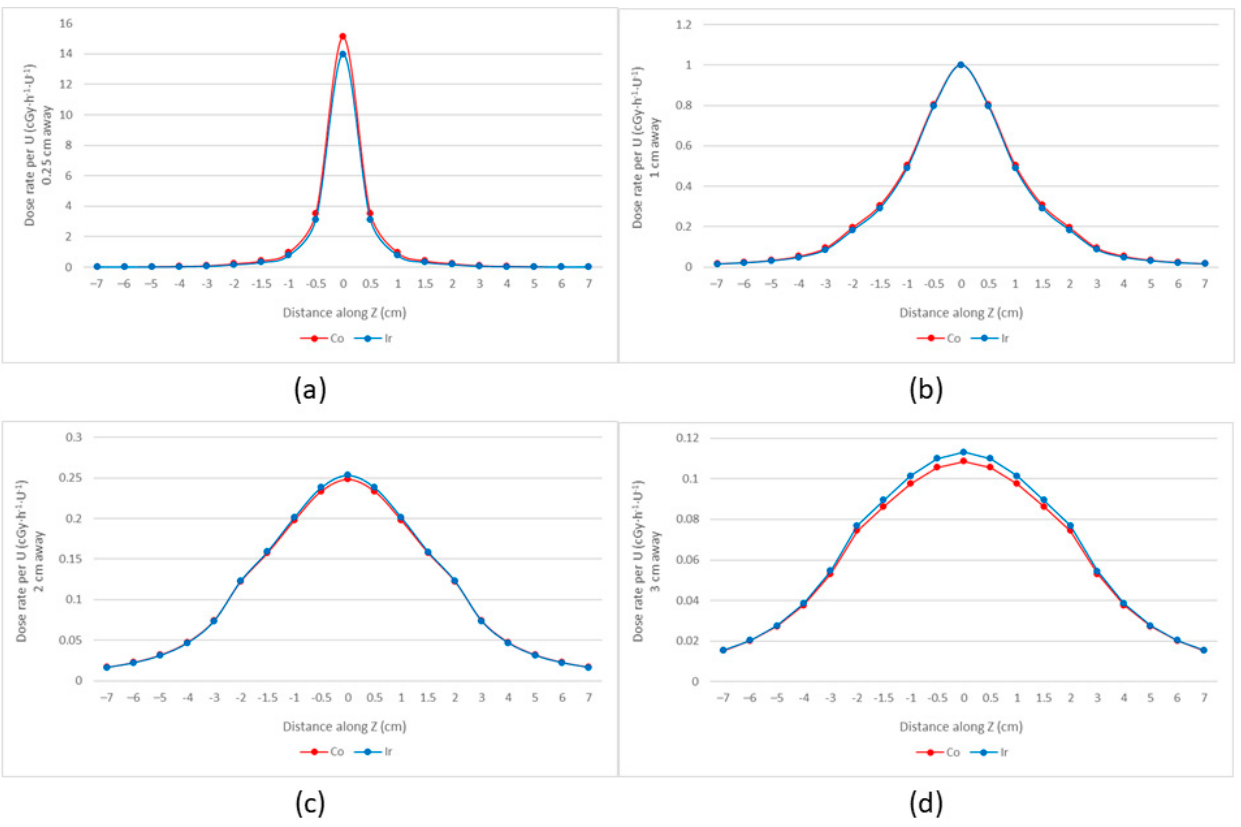
Figure 2. Dose rates of 192Ir (mHDR − V2) and 60Co (Co0.A86) (normalized at y = 1 cm). ( a ) y = 0.25 cm; ( b ) y = 1 cm; ( c ) y = 2 cm; ( d ) y = 3 cm. The 60Co source produced higher dose rates at a distance from the source of less than 1 cm, while the 192Ir source produced higher dose rates at a distance from the source of more than 1 cm.